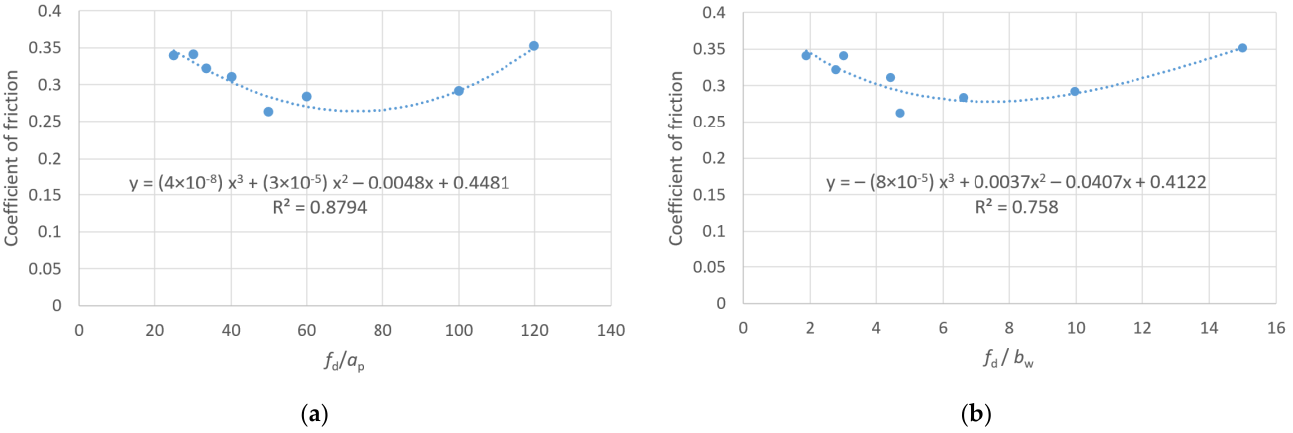
Figure 8. Relation between surface COF and microstructural features. ( a ) Influence of f d / a p . ( b ) Influence of f d / b w .